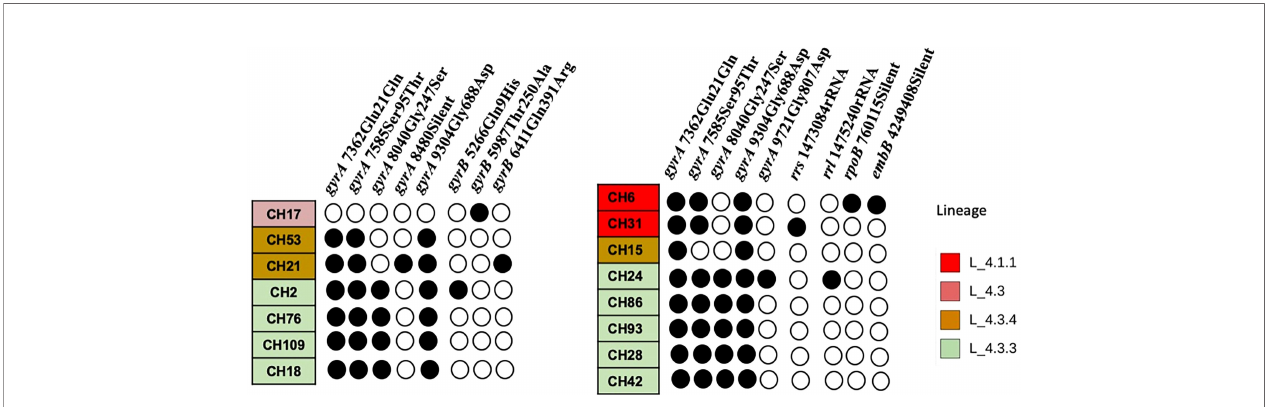
FIGURE 4 | SNP pattern of SIT42 and orphan isolates of genes involved in antituberculosis drug resistance. Mutations observed in DNA gyrase subunit A ( gyrA ), B ( gyrB ), the rrs and 23S rRNA ( rrl ) subunits, the beta subunit of RNA polymerase ( rpoB ), and the arabinosyltransferase subunit B ( embB ) are shown in black circles. The isolates are ordered according to their phylogenetic relationships.